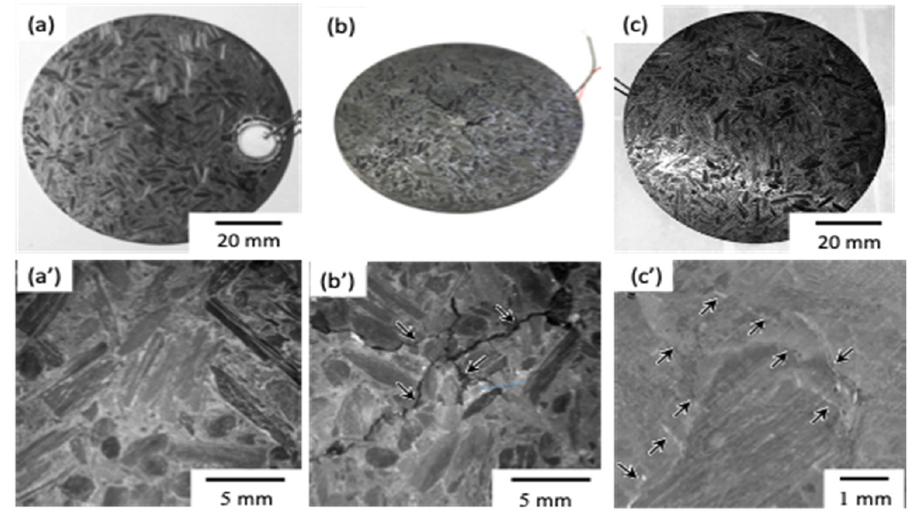
Figure 5. A typical example of impact-tested surface of (C/C)Si/SiC composite: ( a ) original un-damaged, ( b ) damaged B, and ( c ) damaged C, ( a’ – c’ ) detail of the back surface around center.